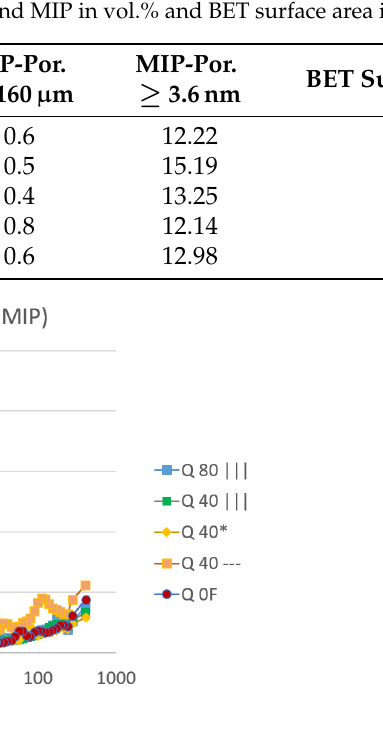
Figure 10. Pore throat size distributions of all five samples determined with